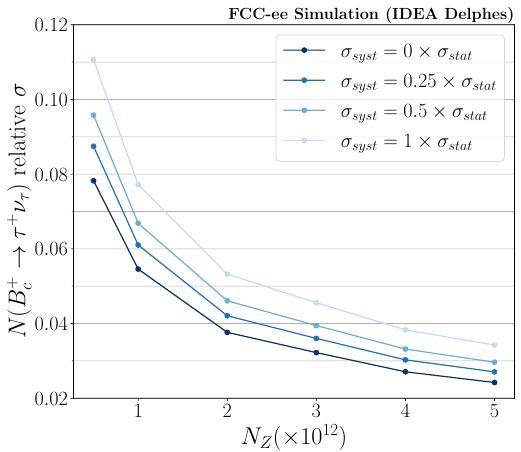
Figure 7 . Relative precision on the signal yield as a function of N Z . The signal yields at each N Z value are taken from the cut optimisation procedure, and the statistical uncertainties are measured in pseudoexperiment fits. Different levels of systematic uncertainty relative to the statistical uncer- tainty are also